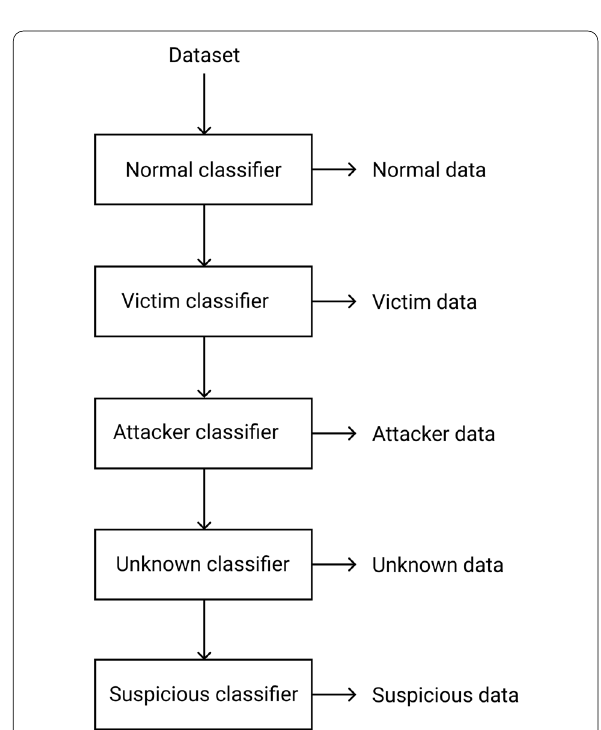
Fig. 10 The hierarchical structure for multi-class classification